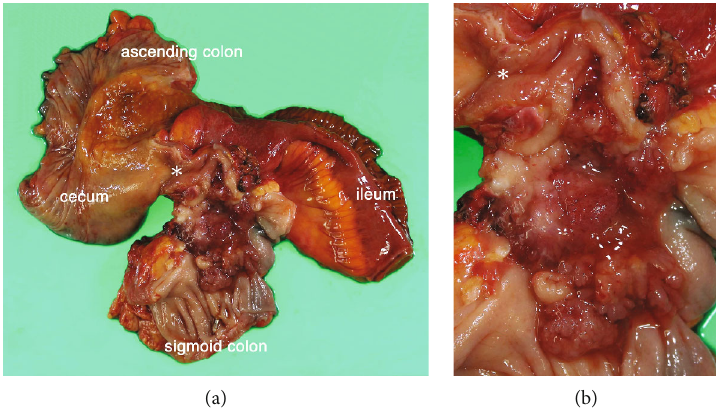
Figure 3: Macroscopic views of the resected specimen. (a) A tumor of 60 × 40mm in size was seen in the distal part of the appendiceal lumen and extended into the lumen of the sigmoid colon with fi stulation. The root of the appendix is indicated by an asterisk. (b) A closer view.